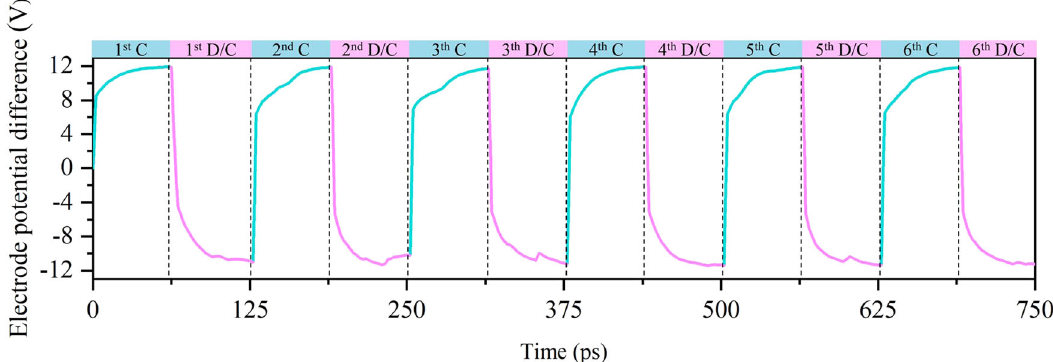
Fig. 2 Cyclic charge-discharge potential difference (voltage) pro fi les between two electrodes during the initial six cycles. An external potential of ±6 V was applied during repeated charge-discharge cycles.